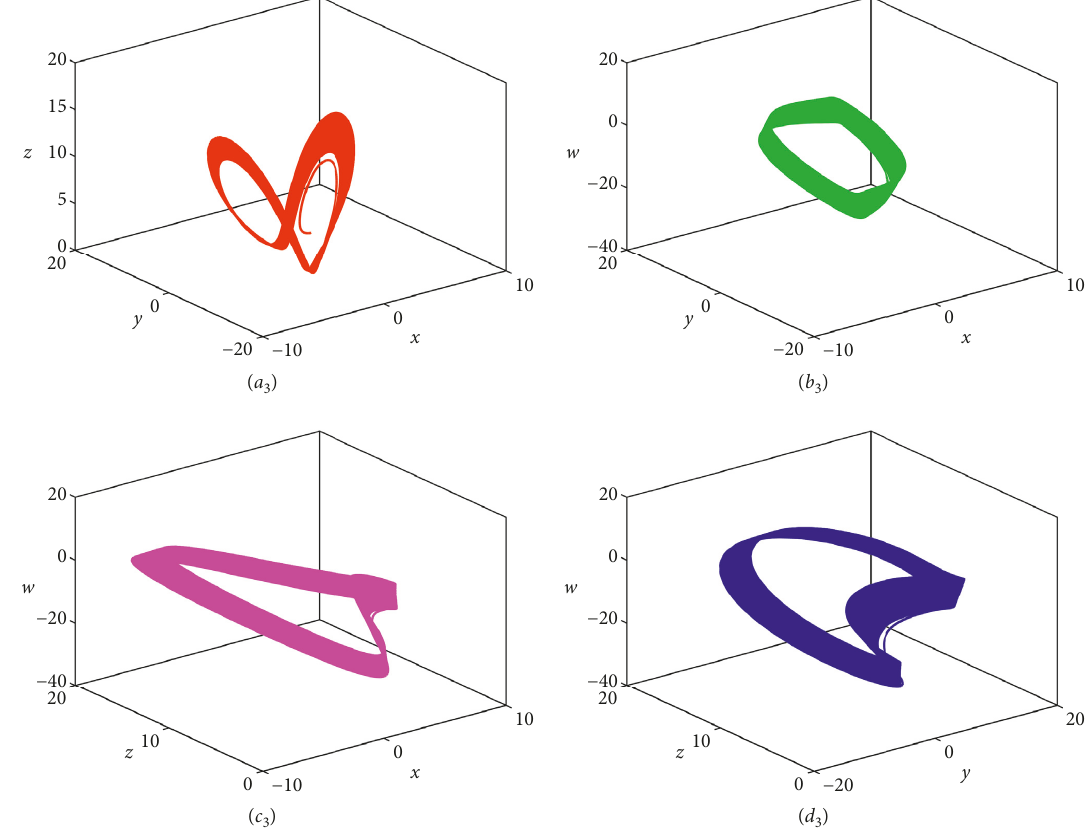
Figure 9: Phase portraits of Experiment 1 with a � 2 , b � 3 ,t � 1000: ( a ) on y − z − w plane; ( d 3